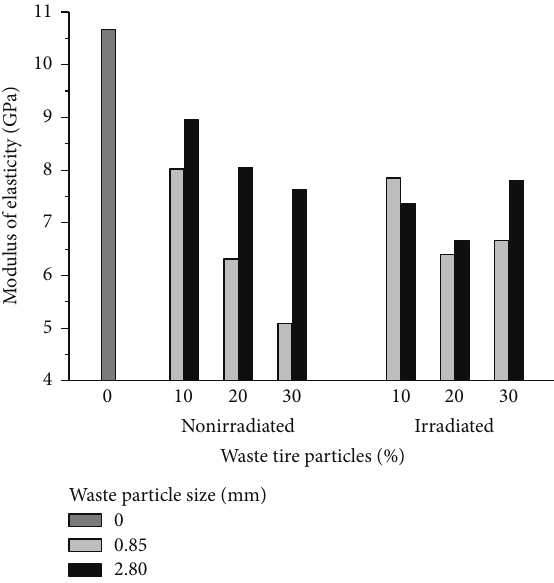
Figure 5: Modulus of elasticity of concrete with waste tire